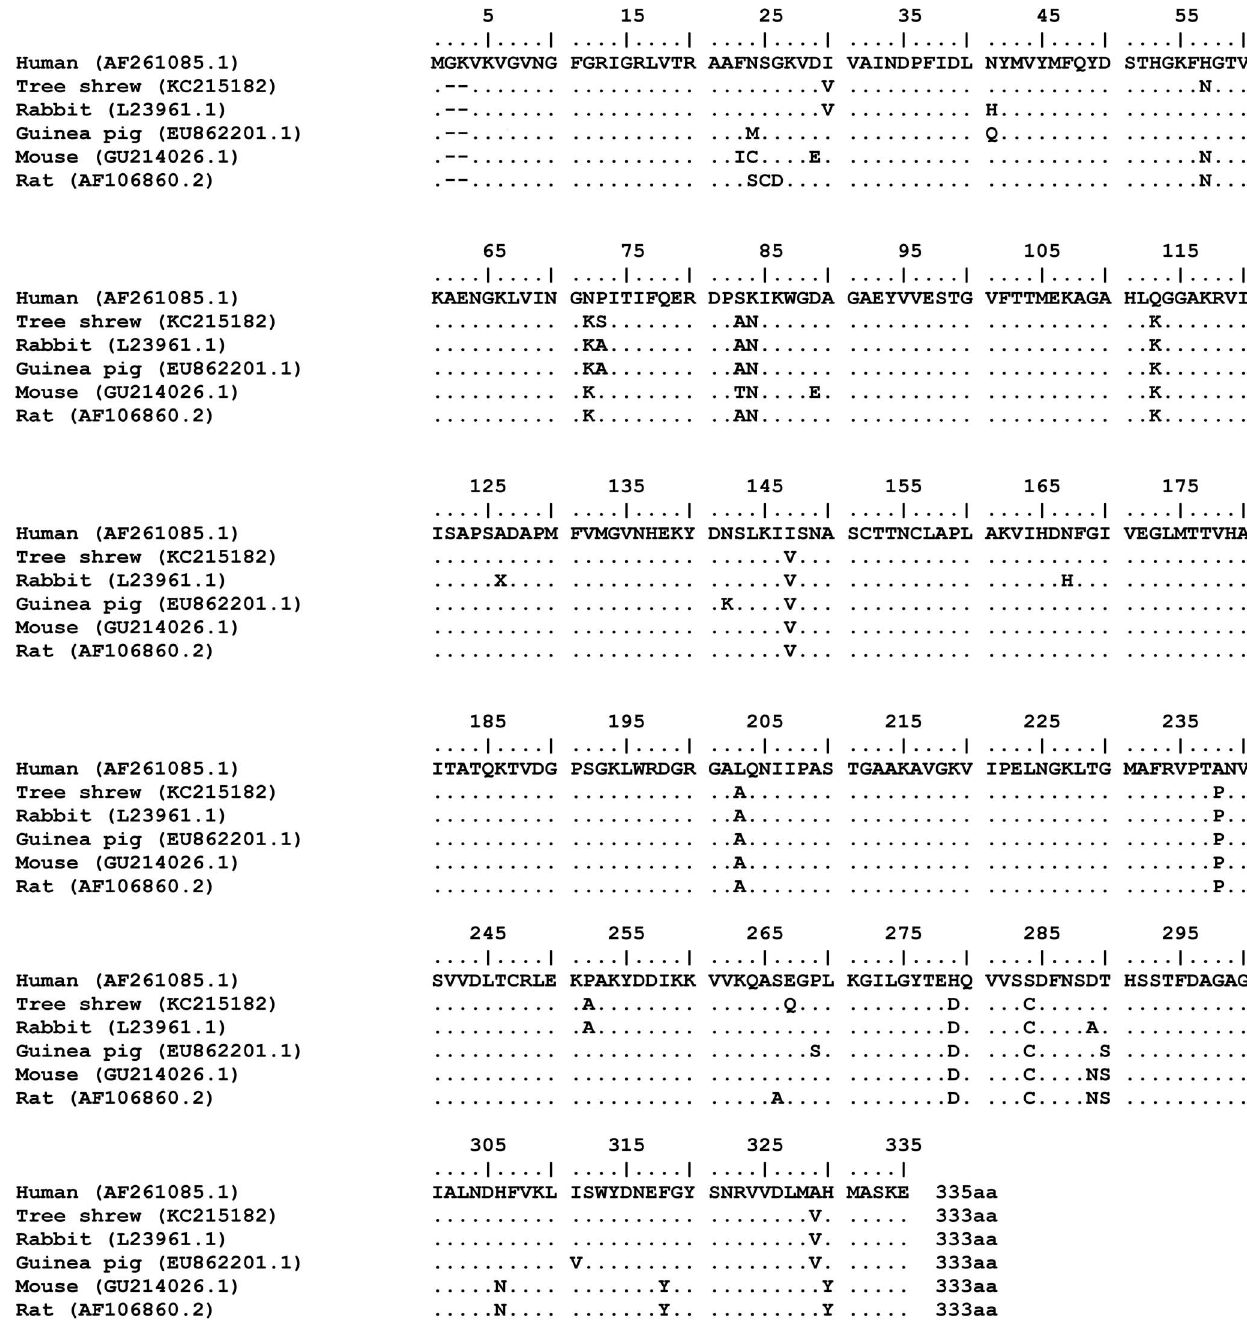
Figure 2. Alignment of GAPDH. Comparison of the deduced full-length amino acid sequences of GAPDH among human, tree shrew, mouse, rat, rabbit and guinea pig. Identical amino acids are shown by a dot, gaps are represented by a dash.